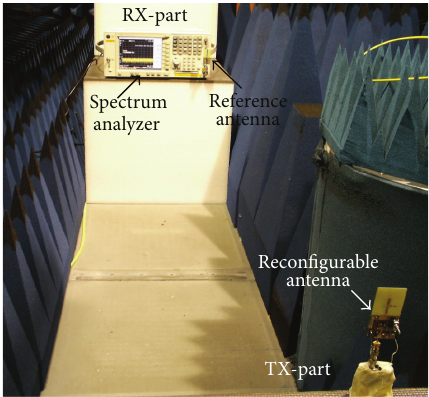
Figure 17: Photograph of the RF-power measurement in the far- field condition.